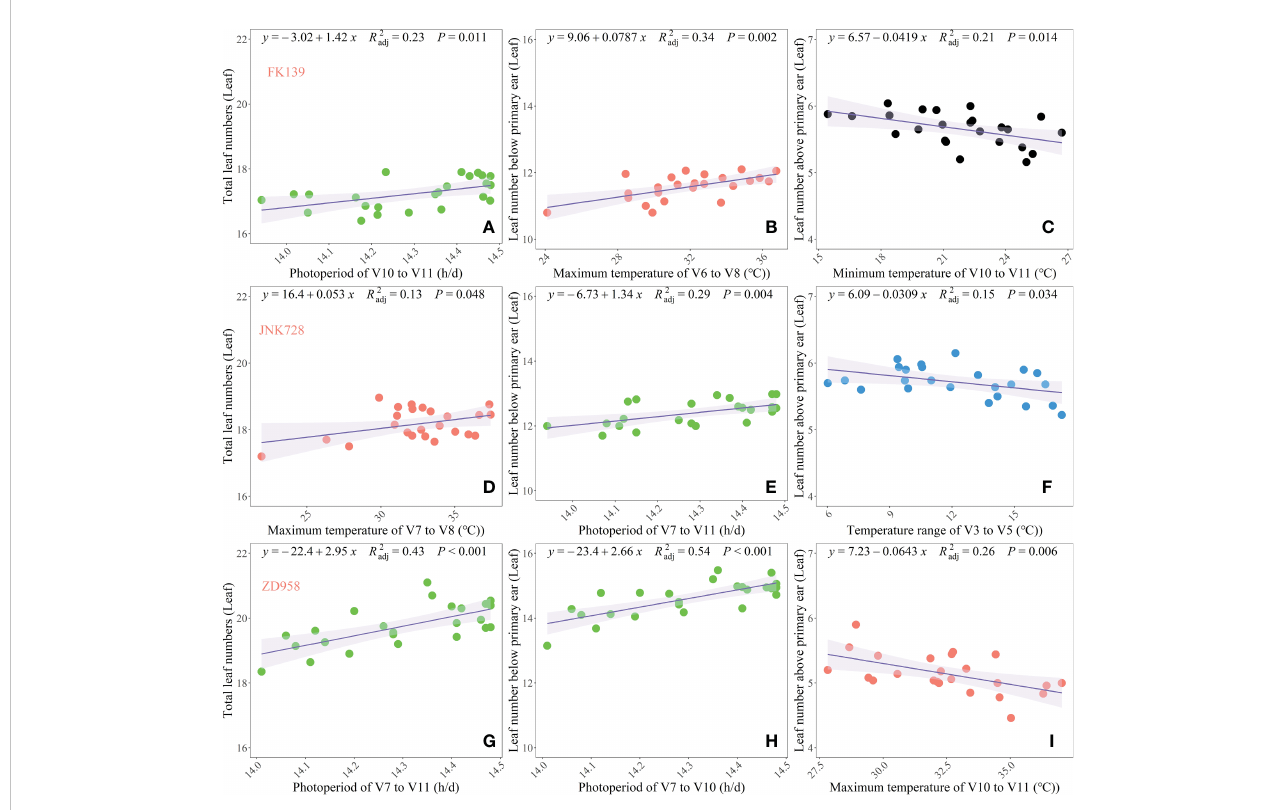
FIGURE 7 Key meteorological factors during crucial growth stages affecting leaf number responses of three maize cultivars. ( A – C ) respectively represent the TLN, LB, and LA of FK139; ( D – F ) respectively represent the TLN, LB, and LA of JNK728; and ( G – I ) respectively represent the TLN, LB, and LA of